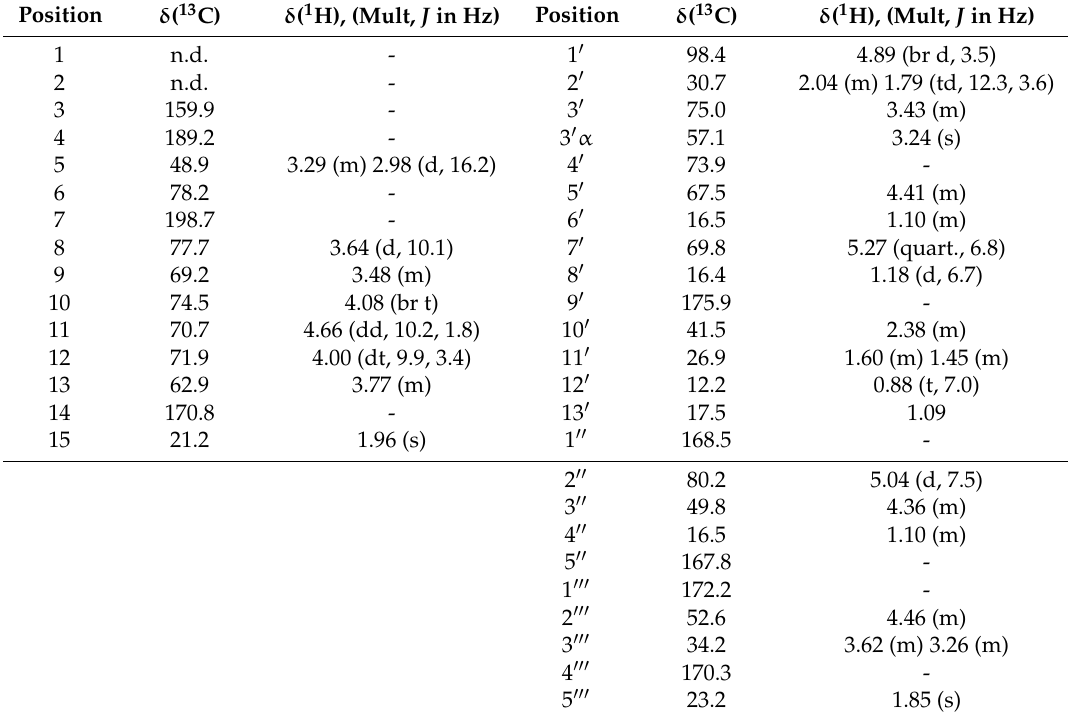
Table 3. NMR data ( δ in ppm) for compound 3 (DMSO- d 6 , 500 MHz, 24 ◦ C). Carbon chemical shifts derived from HSQC and HMBC